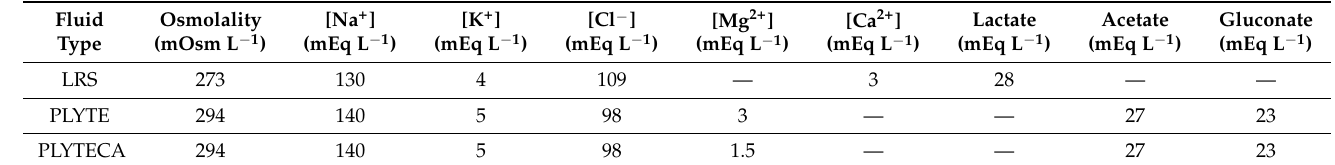
Table 1. Ionic and buffering compositions of PLYTE, PLYTECA and